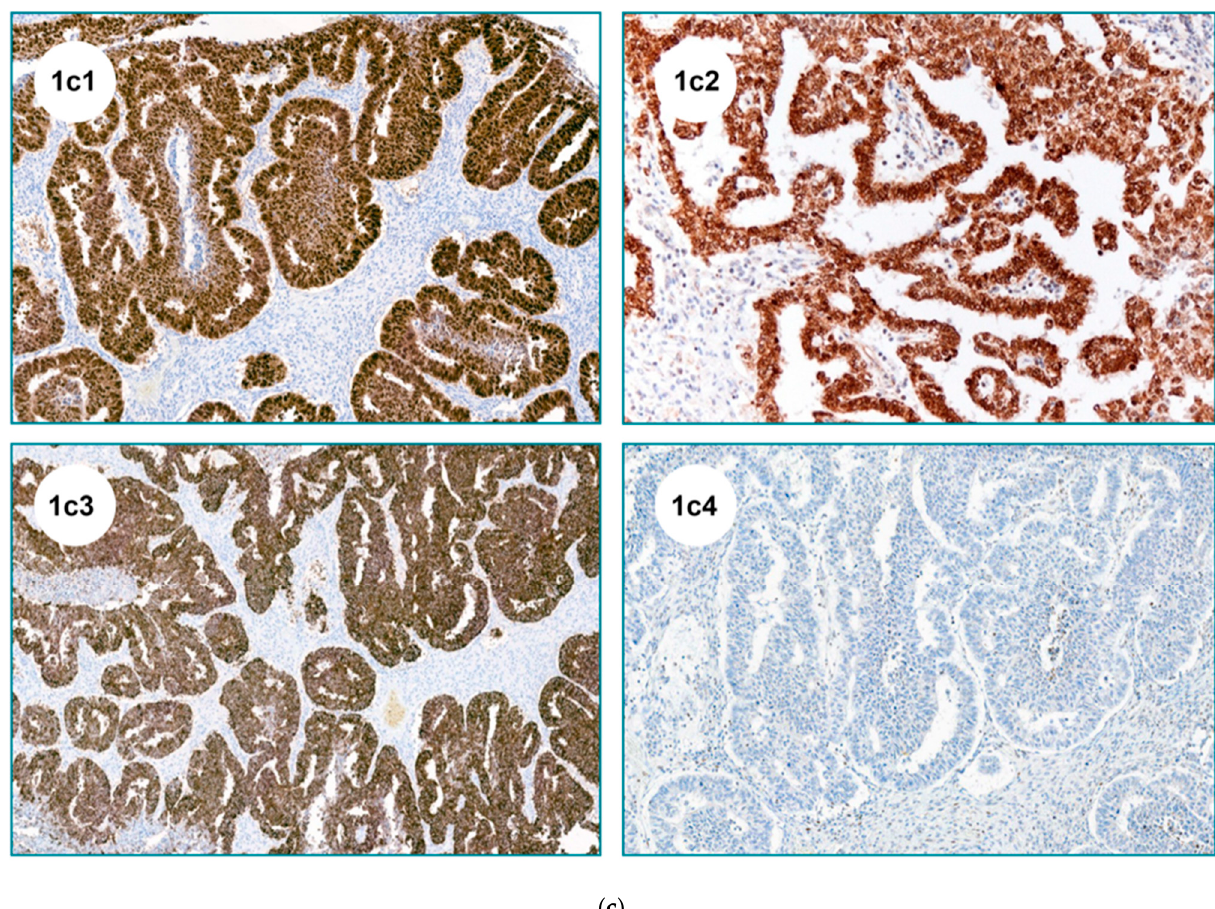
Figure 1. TGCT subtypes in the tumorigenesis of TGCT. ( a ). The epigenetic landscape for germ cells. The germ cells progress from toti-differentiated cells to unipotent cells, and a gene panel of OCT4, SOX2, LIN28, and NANOG (OSLN) can reprogram germ cells for induced pluri- to totipotent stem cells (iPSC). The red boxes show gene panels for iPSC. The progression of the TGCT subtypes implies a loss of chromosomes from tetraploid malignant germ cells over hypertriploid seminoma to hypotriploid embryonic carcinoma. ( b ). Microinvasive germ cell tumor (MGCT). MGCT is the first invasive step in the tumorigenesis of TGCT . MGCT is an intermediary precursor of TGCT that has malignant germ cells inside and outside seminiferous tubules in the testis. The figure shows MGCT stained for OCT4, the protein of POU5F1 . ( c ). Embryonal carcinoma (EC). EC has a positive homogeneous immunohistochemical staining for three transcription factors for induced pluripotent stem cells (OCT4, SOX2, and NANOG) and a homogeneous negative staining for the protein of the tumor suppressor gene, RB1 . EC stained immunohistochemically positive for OCT4 (1c1), SOX2 (1c2), LIN28 (1c3), and immunohistochemically negative for RB1 (1c4).